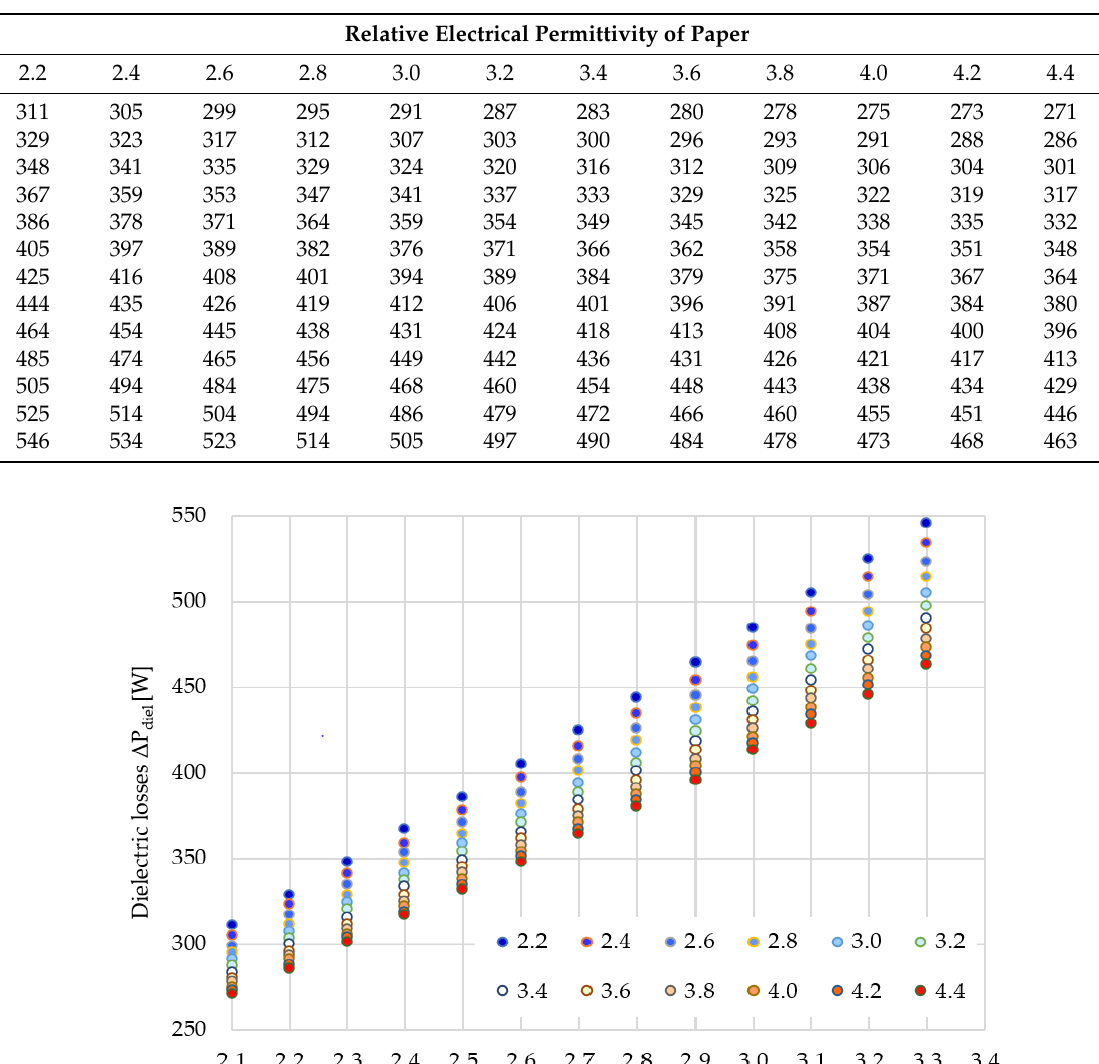
Table 4. Dielectric losses in the selected transformer depending on the electrical permittivity of paper and the electrical insulating liquid used.